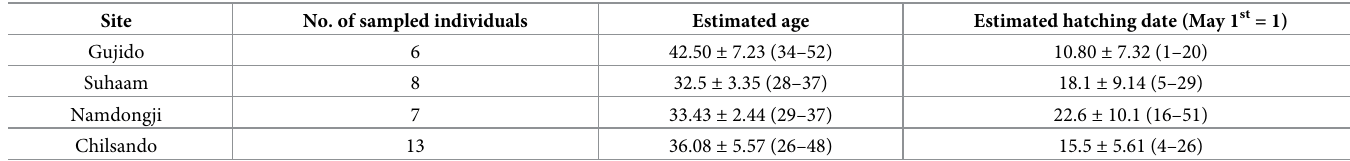
Table 1. The number of Black-faced Spoonbill chicks sampled in each study colony and respective age and hatching date (mean ± SD with a range in parentheses). Site No. of sampled